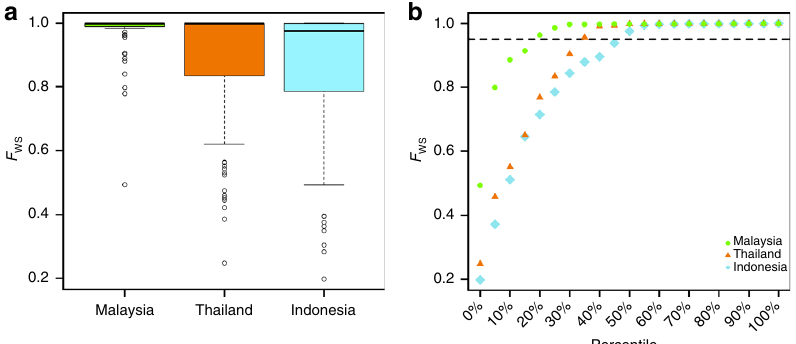
Fig. 1 F WS plots illustrating trends in within-sample infection complexity in Sabah Malaysia, Thailand and Indonesia. Boxplots ( a ) and scatter plots ( b ) of the F WS measure, which provides a gauge of the diversity within individual infections scaled from 0 (high diversity) to 1 (no diversity). The boxplot boxes present the median and interquartile range, with the lower whiskers presenting max(min( x ), quartile 1 – 1.5 × interquartile range). The dotted line in ( b ) illustrates the F WS = 0.95, above which infections are essentially monoclonal. A higher proportion of monoclonal infections are observed in Sabah, Malaysia, relative to Thailand and Indonesia. The plots were generated using genomic data on 259 high-quality